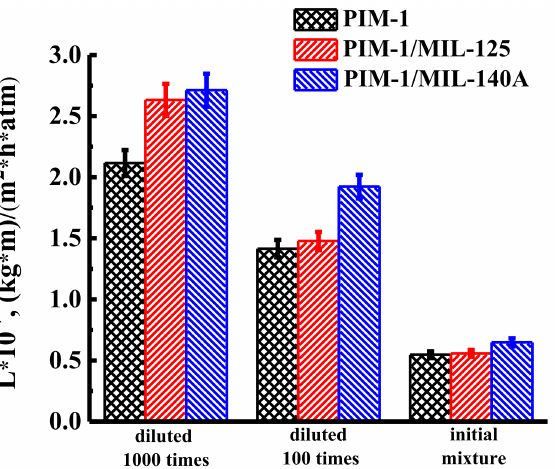
Figure 6. Permeability of PIM-1, PIM-1/MIL-125, and PIM-1/MIL-140A membranes during the nanofiltration at 50 atm: a sample of untreated wastewater (initial mixture), a sample of untreated wastewater, diluted 100 times, and a sample of untreated wastewater diluted 1000